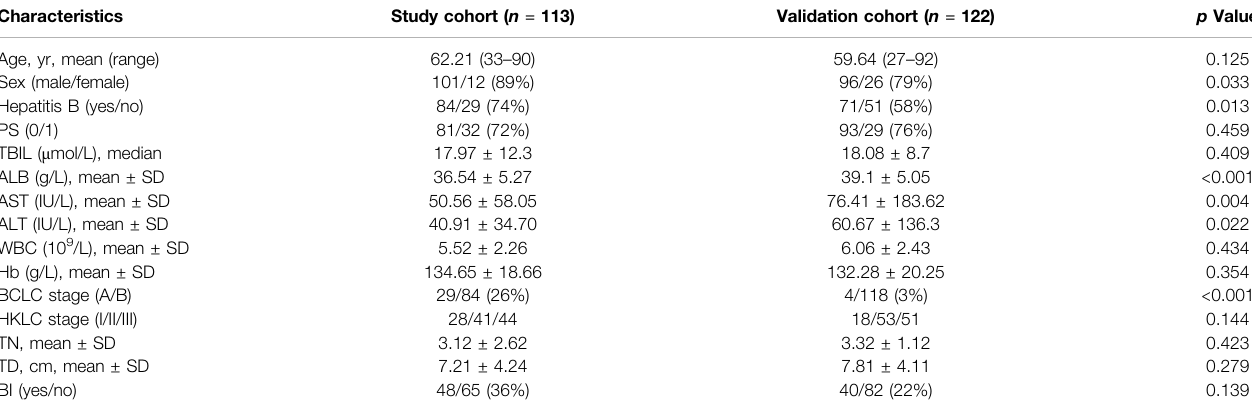
TABLE 3 | Baseline characteristics between the study and validation cohorts. Characteristics